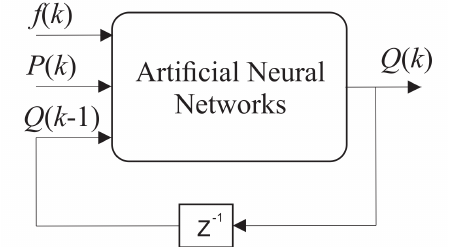
Figure 8. Diagram of ANN-NARX with